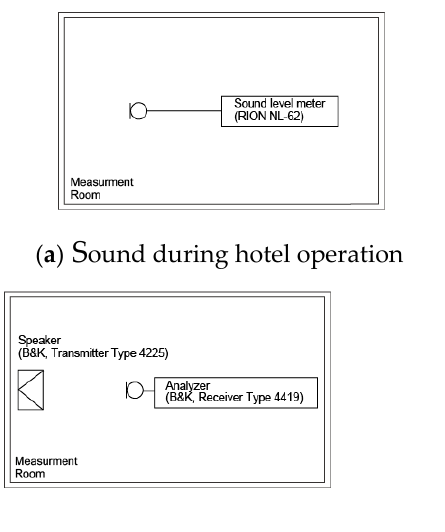
section B-B’; the cross-section lines are shown in Figure 2.